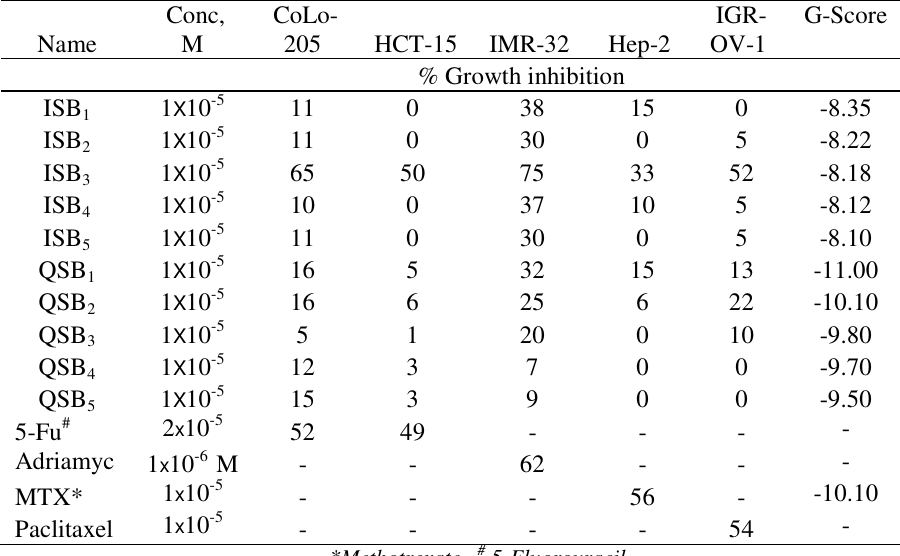
Table 3. Cancer cell-line cyto-toxicity assay and G-scores .